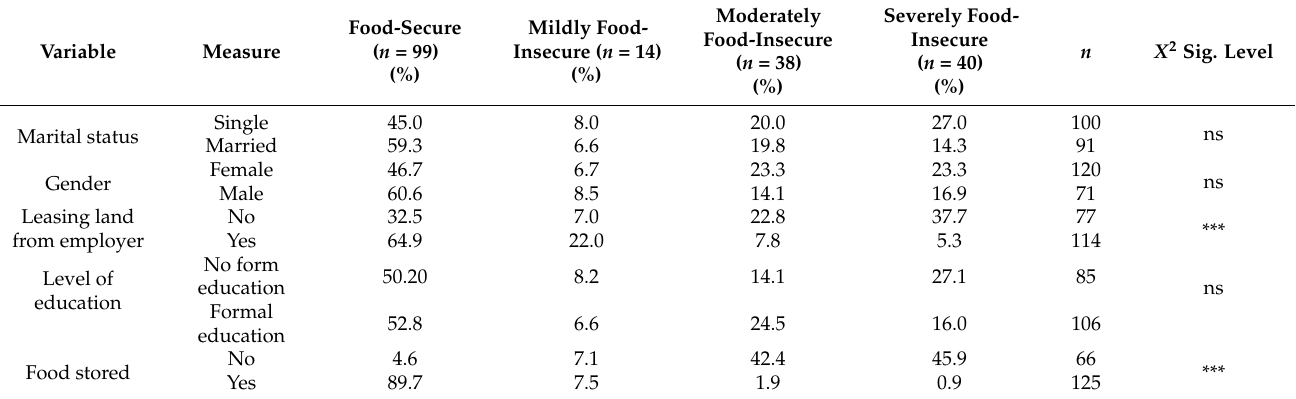
Table 3. Association between food security and socioeconomic parameters.